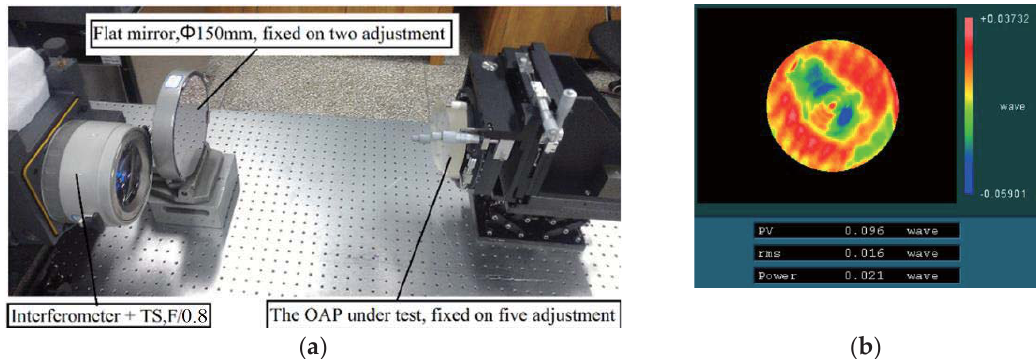
Figure 5. ( a ) Photo of auto-collimation for this OAP; ( b ) the error of flat mirror (PV = 0.096 λ ).